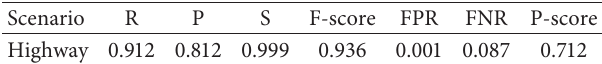
Table 3: Evaluation indicators of the DFCN model in the Highway scenario without